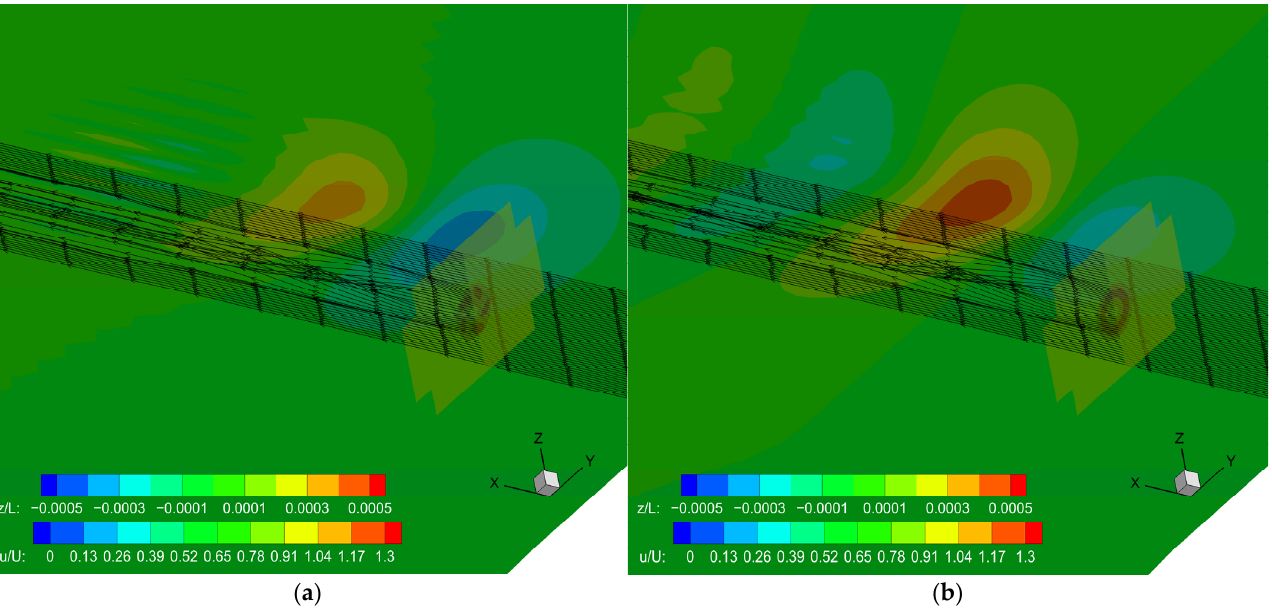
Figure 11. Free surface elevation and streamline ( J = 0.8): ( a ) rotating blade model; ( b ) average model. (The u/U distribution is the slice at propeller plane x/L = 0 and the undisturbed free surface is at z/L = 0).